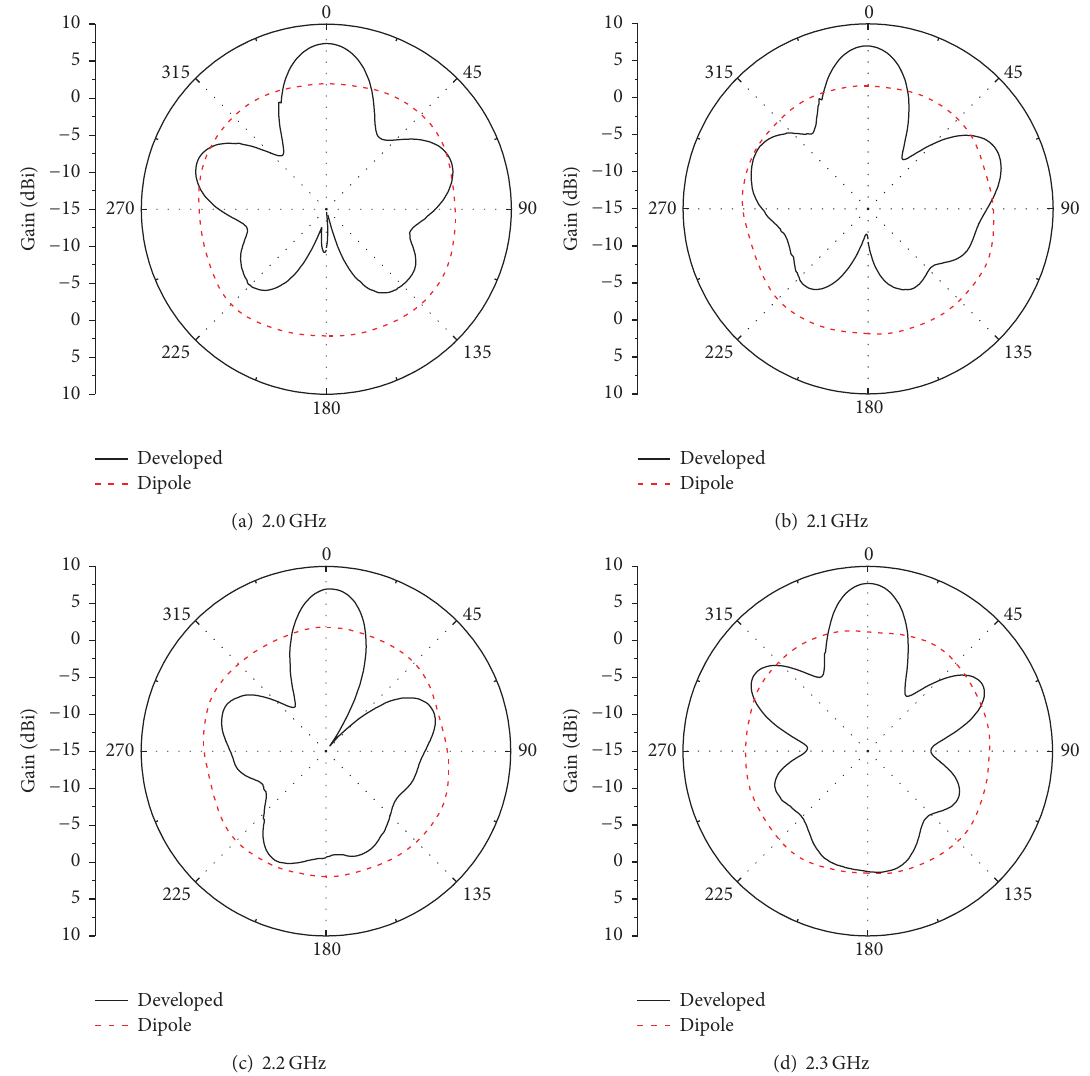
Figure 13: High-gain mode radiation patterns of the developed antenna from 2.0 GHz to 2.3